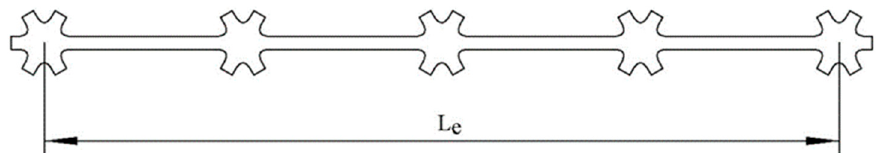
Figure 4. Sampling method for tensile test at room temperature.